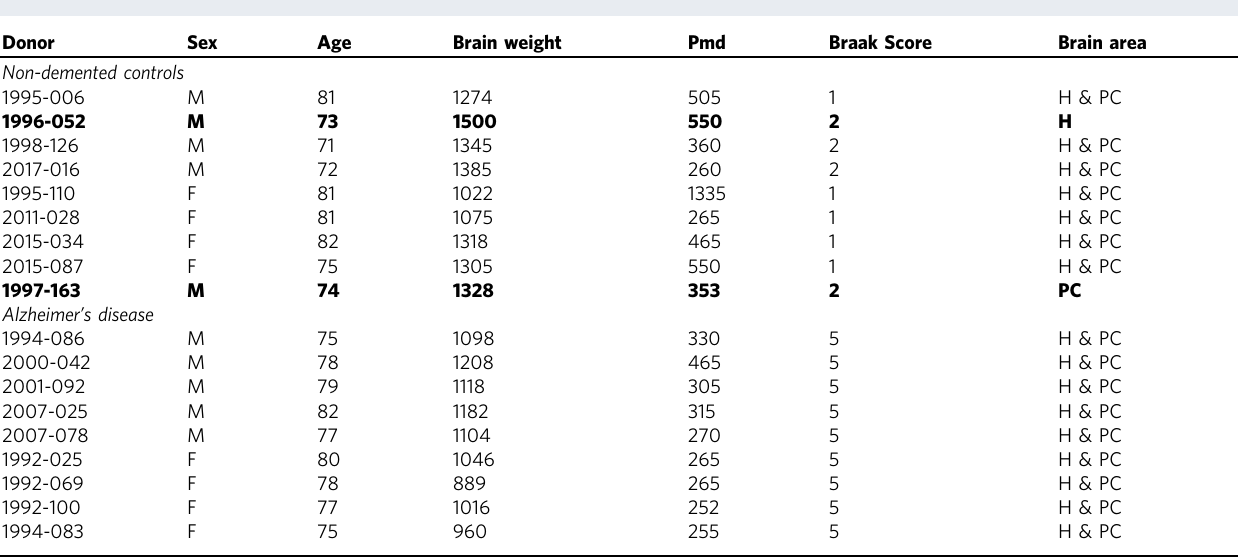
Detailsof hippocampalandparietalsamplesobtainedfrom theNetherlandsbrain bank. Sampleswereobtained fromthe sameindividualsexcept Donor1996-052(hippocampus)was replacedbyDonor 1997-163 (parietal cortex); these samples are highlighted in bold text. Pmd post-mortem delay, H hippocampus, PC parietal